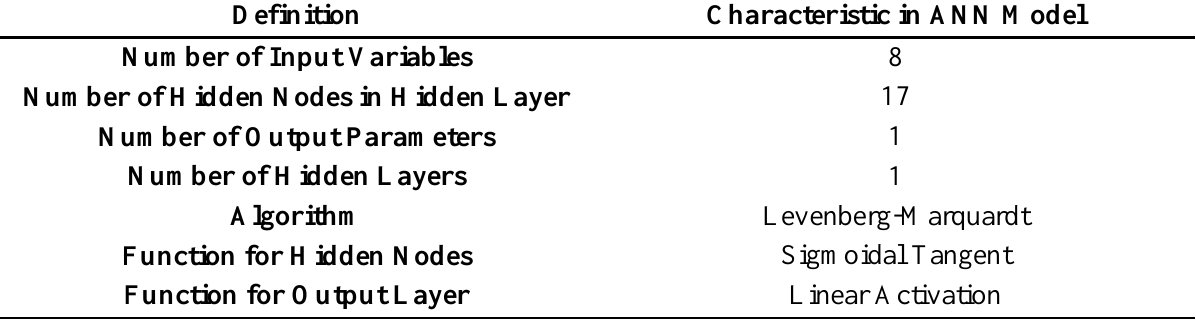
Characteristics of proposed ANN model in Matlab software.